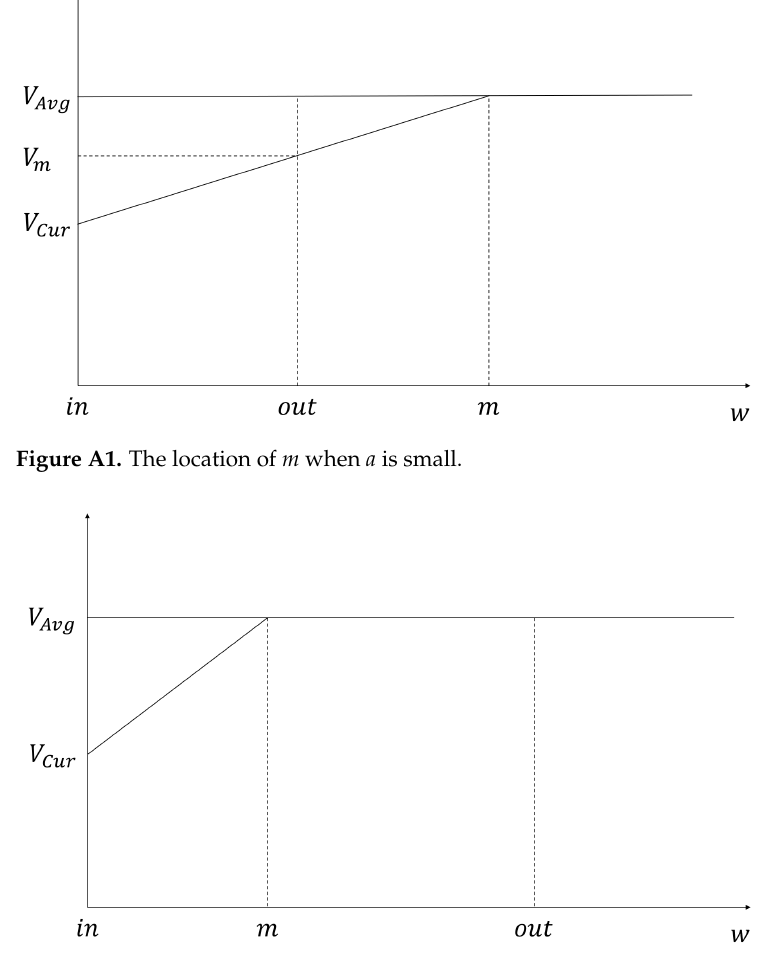
Figure A2. The location of m when a is